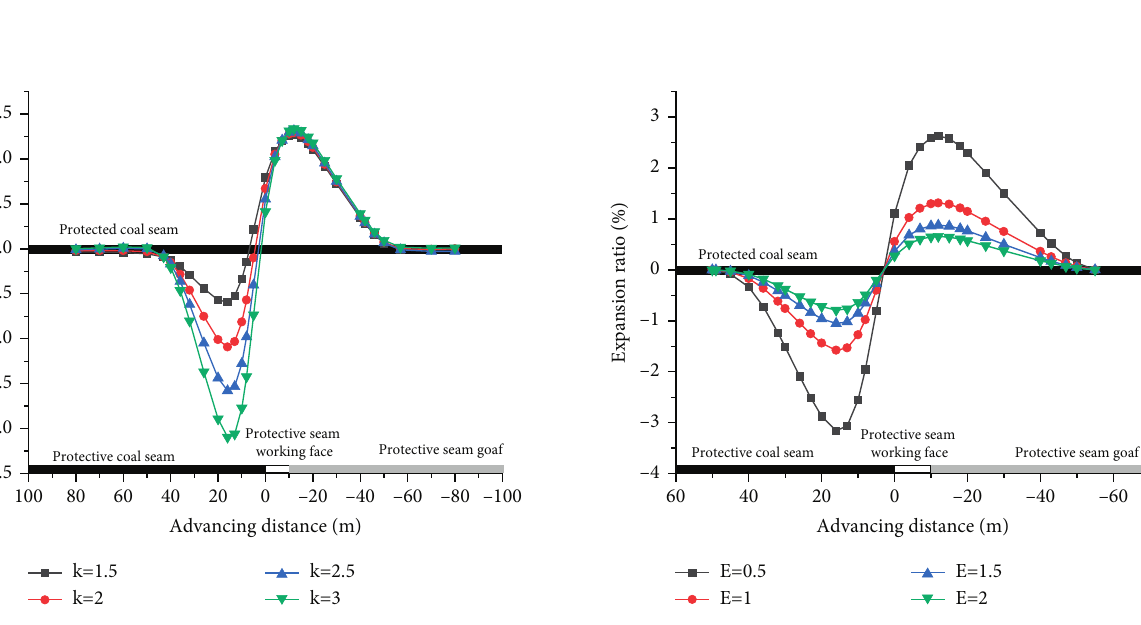
Figure 5: Variation curve of expansion rate with different stress concentration coefficients.